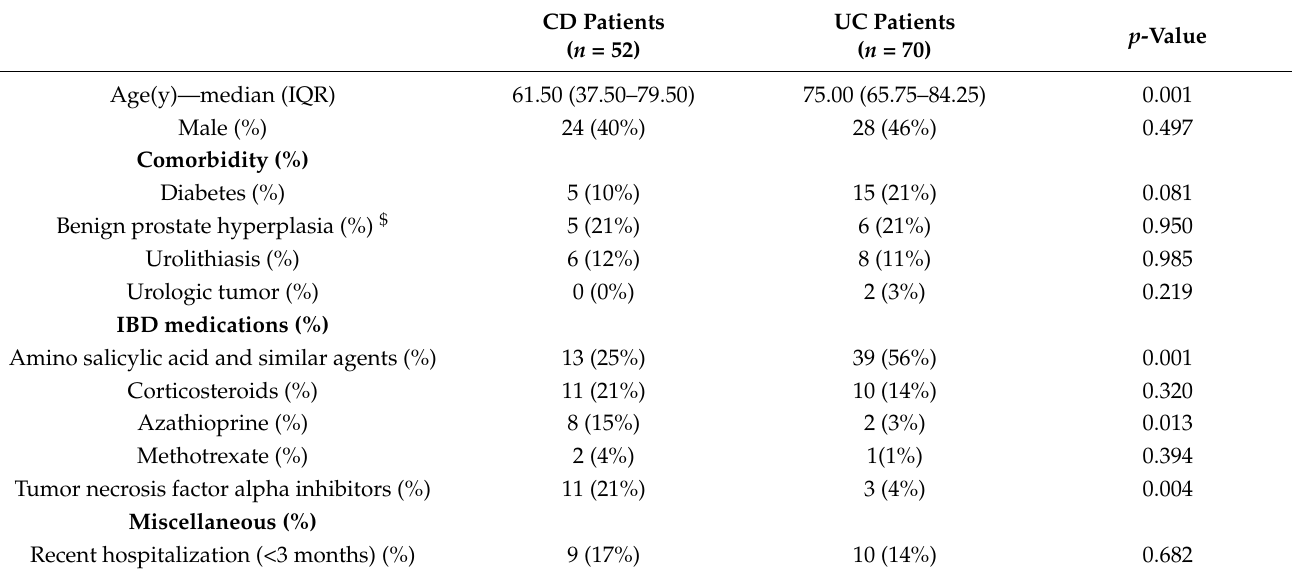
Table 2. Baseline characteristics: Chron’s disease (CD) patients vs. ulcerative colitis (UC)